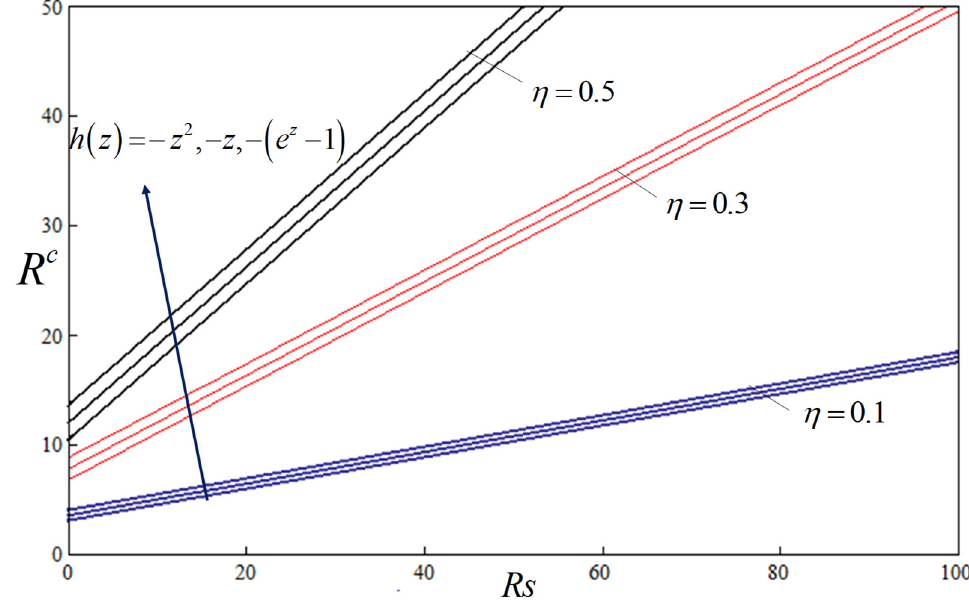
Figure 15. Plot of R c versus Rs for different cases of positive variable gravity functions for various Figure 15. Plot of c R versus Rs for different cases of positive variable gravity functions for var- η values of η with Le = 0.5, Rs = 10, ξ = 0.5, η = 0.5 and δ = with 0.5, 10, 0.5, 0.5 Le Rs ξ η= = = = and 0.5. δ= ious values of